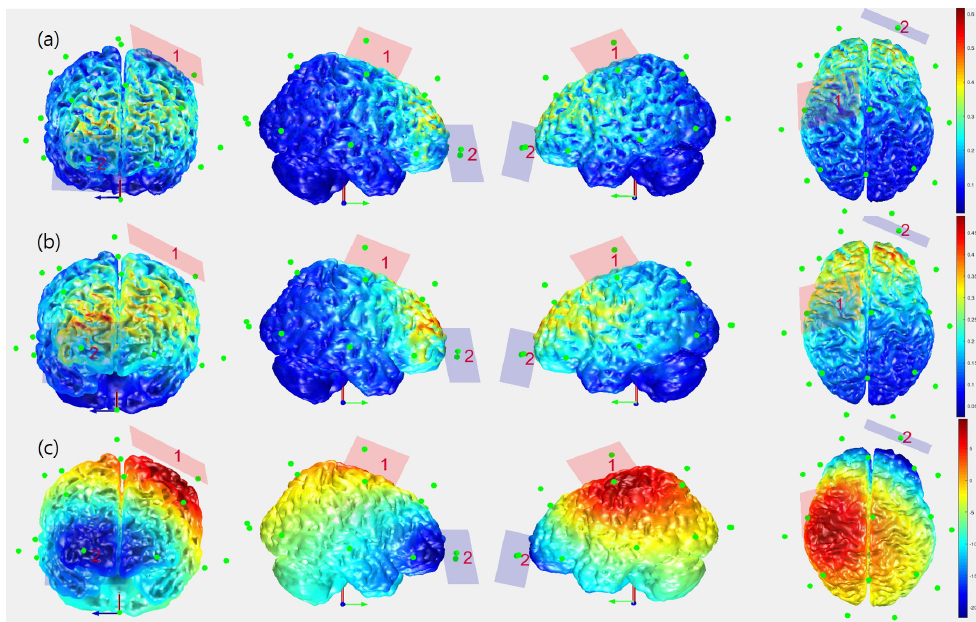
Fig. 3. 3D map of tDCS current flow using COMAT2. Simulation of (a) current density, (b) electric field intensity, and (c) electric potential induced by 2 mA tDCS with the anode (5 × 7 cm) over the left M1 (C3) and the reference electrode (5 × 7 cm) over the right supraorbital area (Fp3). Green dots denote the international 10–20 system of electrode placement. Coronal, right, left, and superior view of the brain are presented (from left to